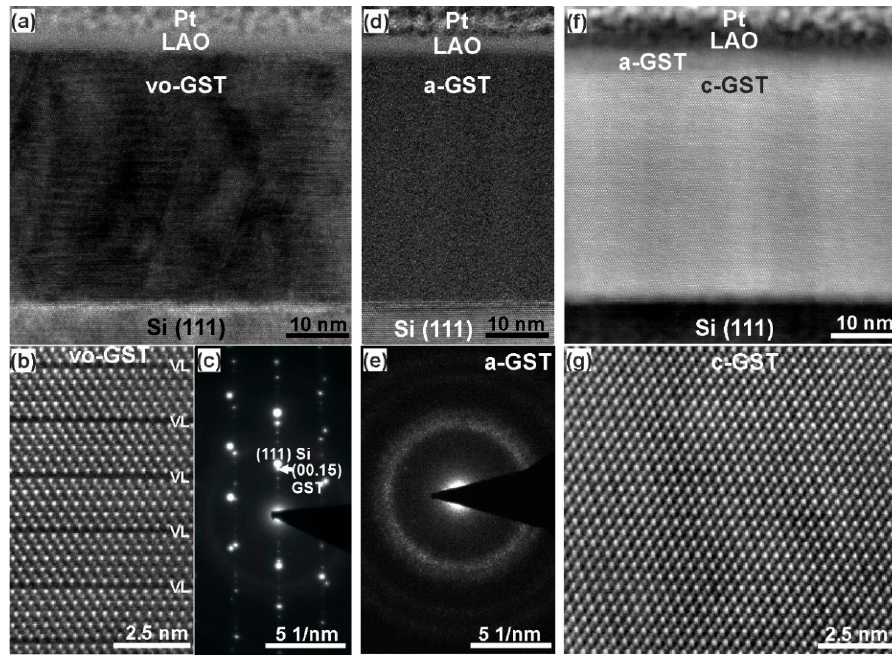
Figure 2. ( a ) BF-TEM and ( b ) HAADF-HRSTEM images of an as-deposited vo-GST thin film. The dark lines in ( b ) are VLs. The bright dots in ( b ) are Te atomic columns whereas the darker dots are mixed Ge/Sb atomic columns. ( c ) SAED pattern showing 5-fold periodicity in the as grown thin film confirming the presence of periodically spaced VLs. ( d ) BF-TEM image and ( e ) SAED pattern of amorphized GST thin film. ( f ) and ( g ) HAADF-HRSTEM images of recrystallized GST thin film, showing epitaxial formation of c-GST phase. Viewing direction is vo-GST [11–20] || Si [1–10] || c-GST